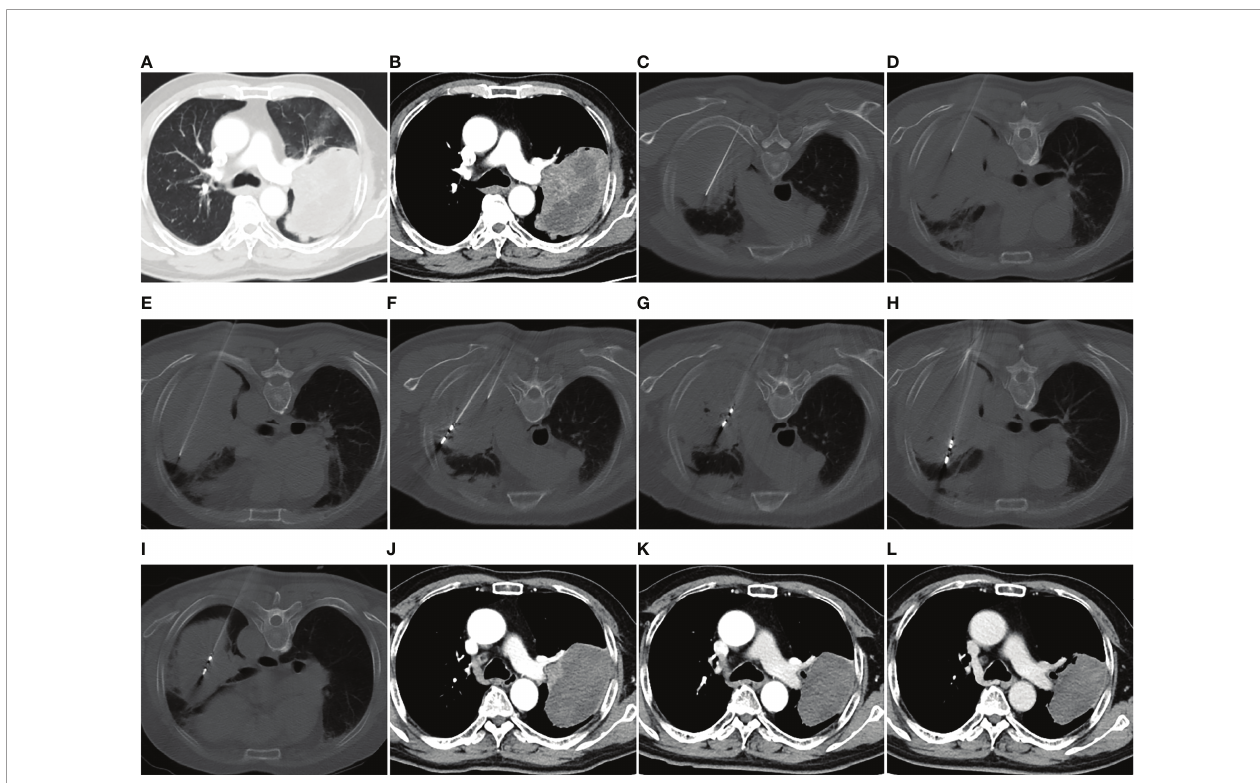
FIGURE 1 | MWA + ITC treatment of a large squamous cell lung cancer in the left upper lobe of a 69-year-old man. Enhanced CT scan in the pulmonary window (A) and mediastinal window (B) showing a mass with a maximum diameter of 11.5 cm adjacent to the left pulmonary artery. (C – E) Direct injection of 40 mL aqueous solution containing 80 mg cisplatin into the mass via three 21-gage Chiba needles at a multisite. (F – I) MWA using four antennae at multisite and multisession with an ablation power of 60 W and a cumulative ablation time of 52 min. (J) Enhanced CT scan at 1-month follow-up after MWA + ITC showing an almost complete necrosis of the ablation zone. (K, L) Enhanced CT scan at 3- and 9-month follow-up after MWA + ITC showing gradually involuting fi brosis of the necrotic zone and no local residue. MWA, microwave ablation; ITC, intratumoral chemotherapy; CT, computed